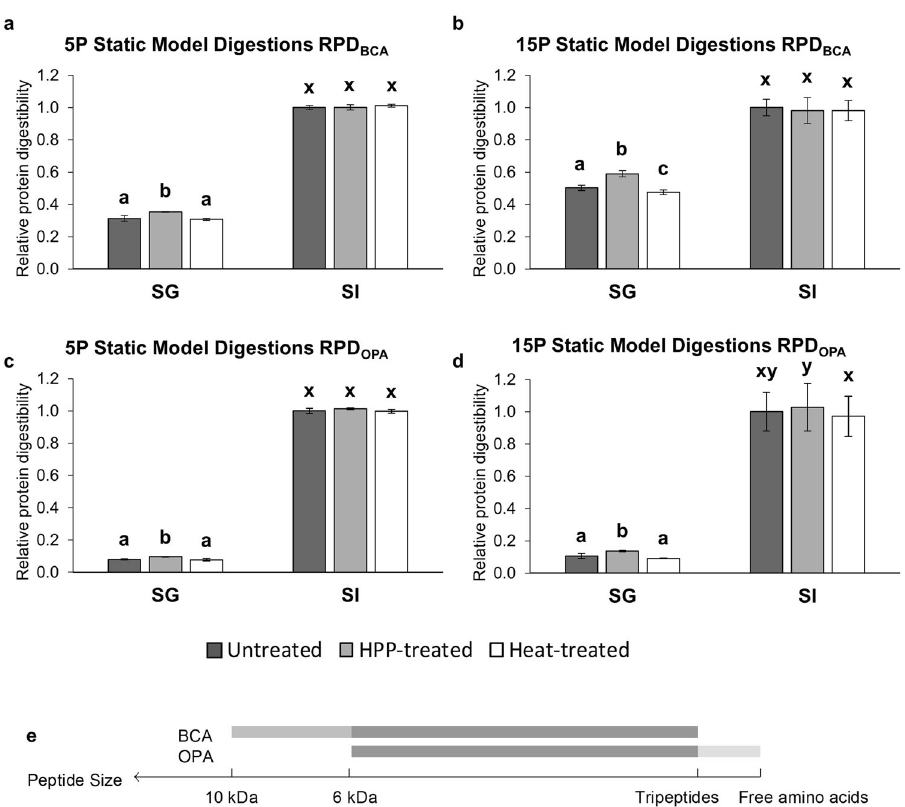
Fig. 3 Average relative protein digestibility as determined by the BCA (RPD BCA ) and OPA (RPD OPA ) assays for static digestions of pea protein concentrate with 5% (w/w) protein (5 P) and 15% (w/w) protein (15 P). The average relative protein digestibility (unitless) for a 5